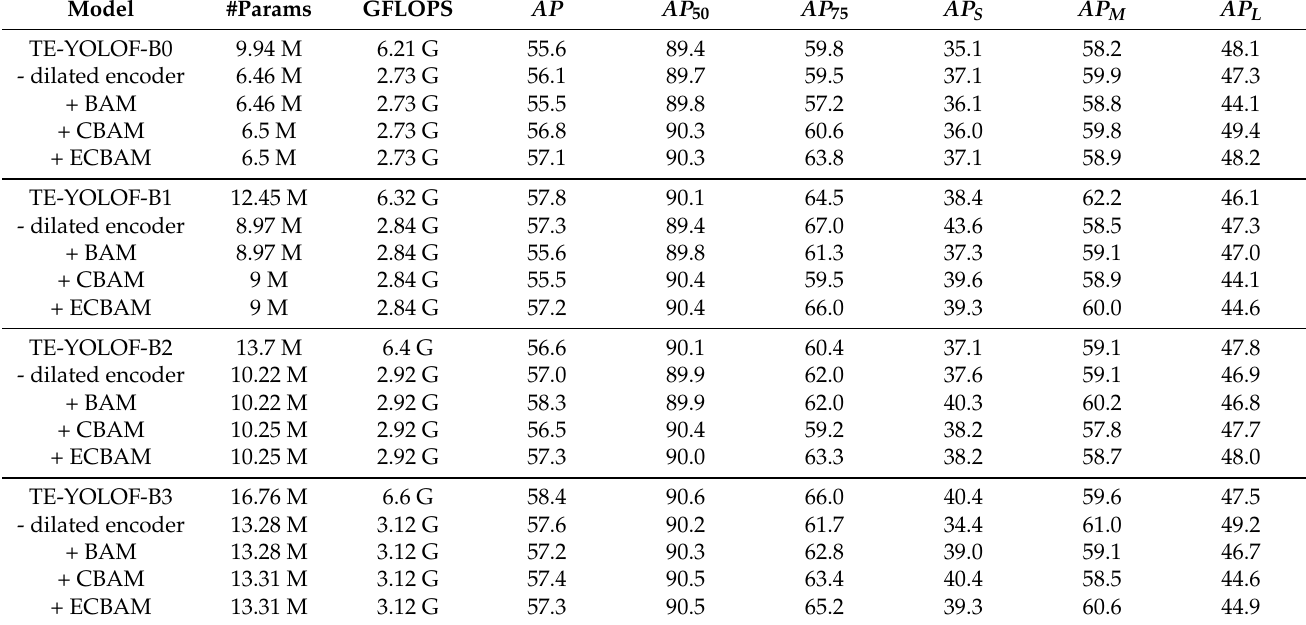
Table 1. Comparison with TE-YOLOF on the BCCD validation set. Models marked with the suffix ’B(N)‘ adopt EfficientNet-B(N) as backbone by default. ‘- dilated encoder’ represents that TE-YOLOF does not use the dilated encoder to achieve feature enhancement, and uses the 1 × 1 conv to reduce the channels from backbone to the default number of 512. ‘+ BAM’ represents using the spatial attention mechanism in CBAM to achieve feature enhancement, while this module is placed in the original dilated encoder location. ‘+ CBAM’ represents using the original attention mechanism in [17], which contains the channel attention mechanism and the spatial attention mechanism. ‘+ ECBAM’ represents using the Enhanced Channel Attention Module we proposed with the spatial attention mechanism in